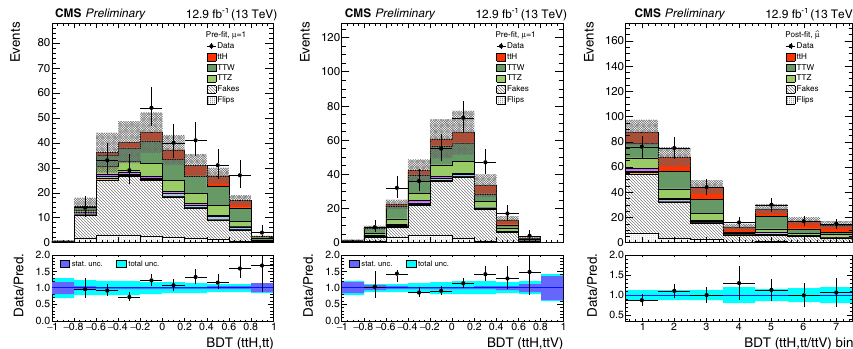
Figure 10. Same-sign dilepton channel: distributions of the BDT classifier outputs shown before the signal extraction fit (x2), trained against t¯t (left) and t¯tV (middle). Post-fit distributions and uncertainties of the combi- nation of the BDT classifier outputs in the bins used for signal extraction (right) [8].